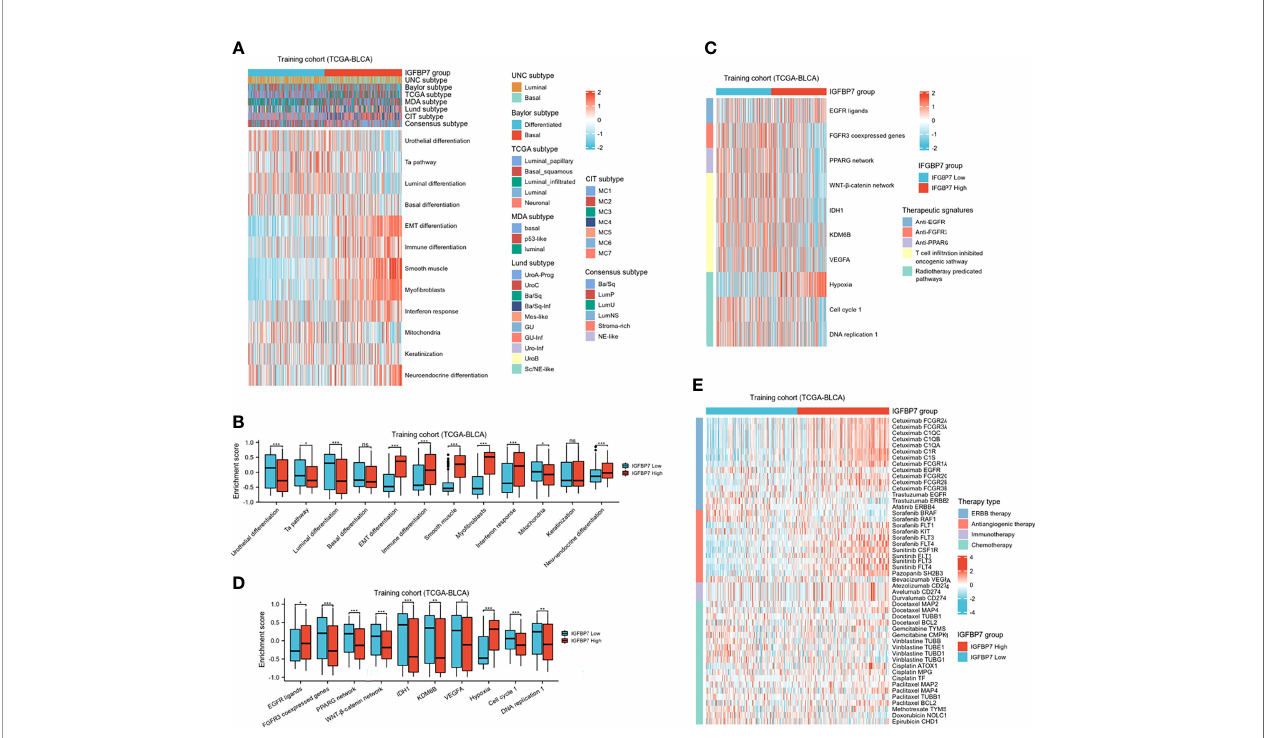
FIGURE 6 | IGFBP7 predicts the molecular subtype and the therapeutic response to several therapies in BLCA. (A) Correlations between IGFBP7 and molecular subtypes using different algorithms and bladder cancer signatures. (B) The enrichment scores of 12 molecular subtype-speci fi c signature in the high- and low- IGFBP7 groups. (C, D) Correlations between IGFBP7 and the enrichment scores of several therapeutic signatures. (E) Correlation between IGFBP7 and the BLCA- related drug-target genes obtained from the Drugbank database. *p< 0.05; **p<0.01; ***p<0.001. ns, no signi fi cance; ns, p ≥